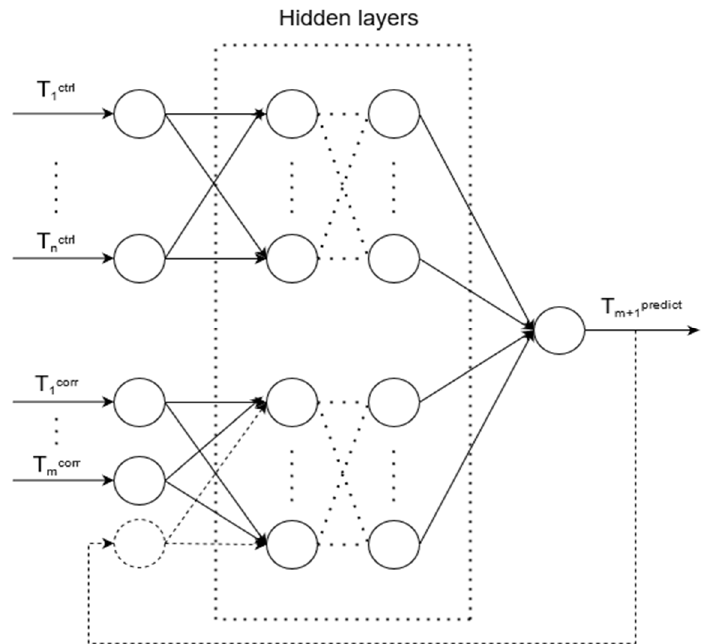
Figure 8. Artificial neural network structure for predicting measurements, where T 1ctrl , ..., T mctrl are input data representing time-series data from the control pyrometer, T 1corr , ..., T mcorr are input data representing time-series data from the control pyrometer, and T m+1predict is an output value representing the predicted measurement. Over time, the forecasting accuracy will gradually decrease, since the proportion of predicted rather than actual values in the input data will increase.